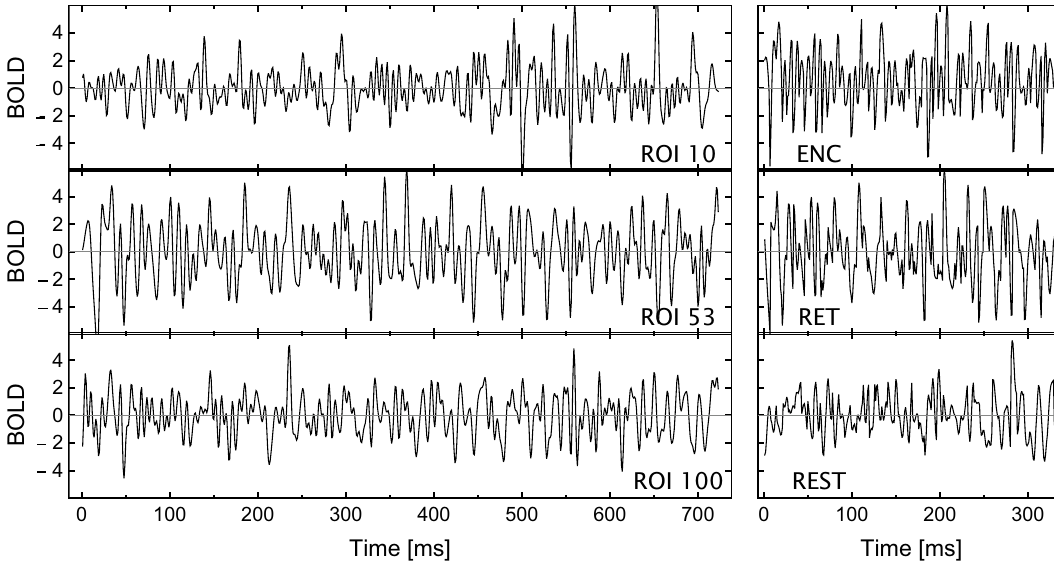
Figure 8. Examples of BOLD time series (left) from ROIs located in Dorsal Right, Visual II and Cerebellum RSNs during semantic task and (right) from ROI 53, Occipital_Inf_L, during memory encoding and retrieval in the same task, and resting